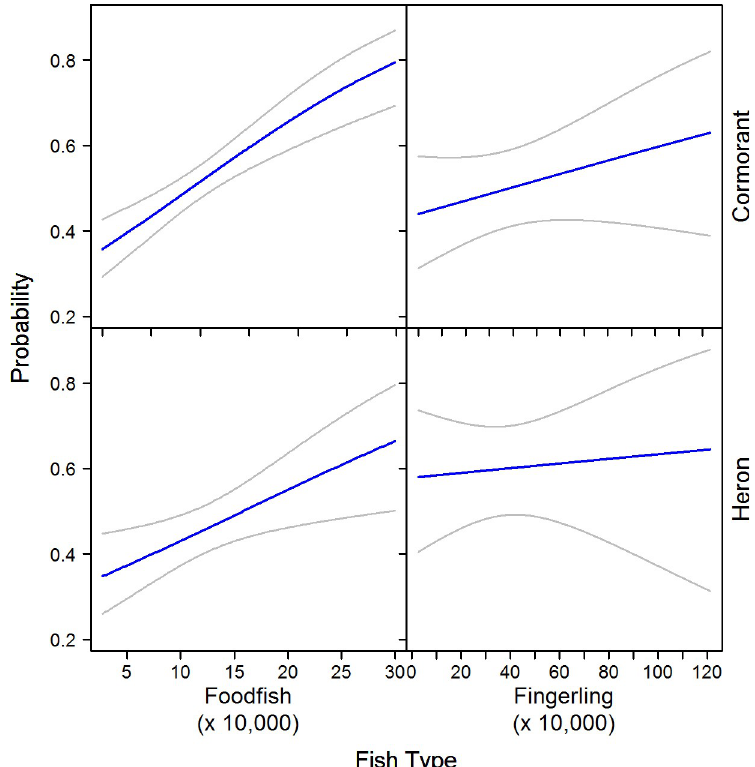
Fig 6. Interaction effect of fish type and fish abundance on the probability (+95% CI) of cormorants and herons use of catfish ponds in the Mississippi Delta. Estimates were made using logistic regression models of bird presence and absence on catfish ponds while holding all other variables at their